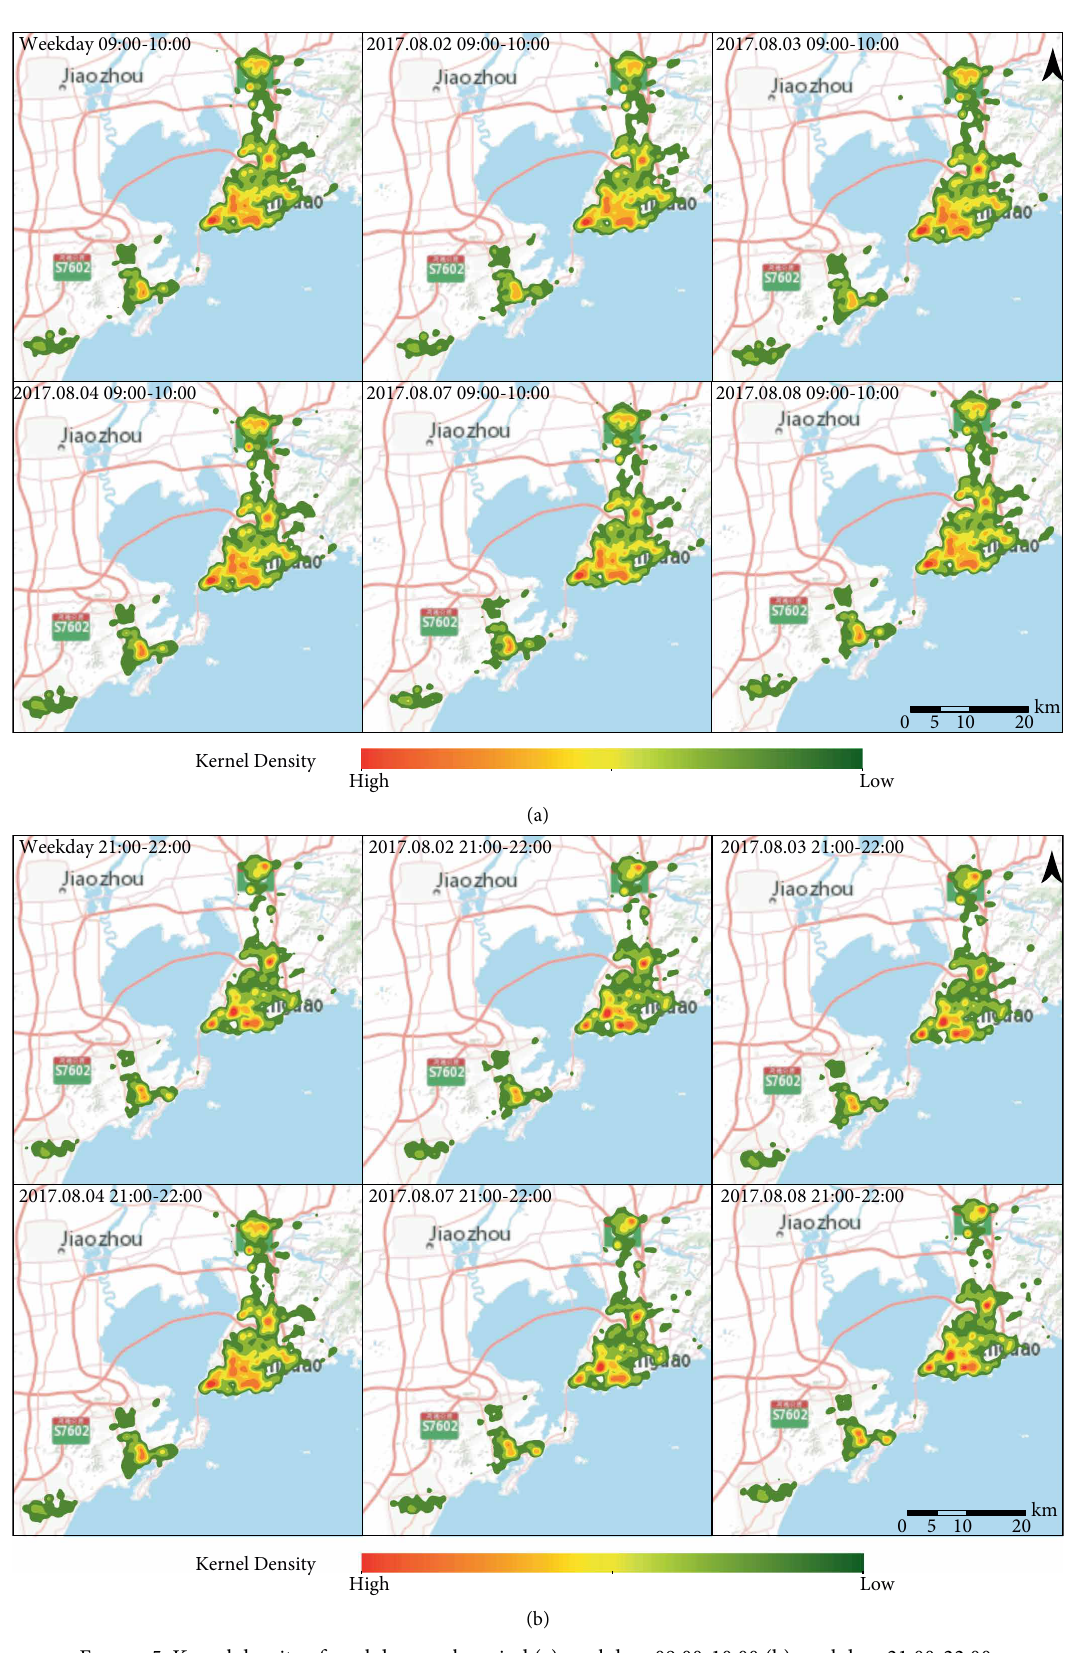
Figure 5: Kernel density of weekdays peak period (a) weekdays 09:00-10:00 (b) weekdays